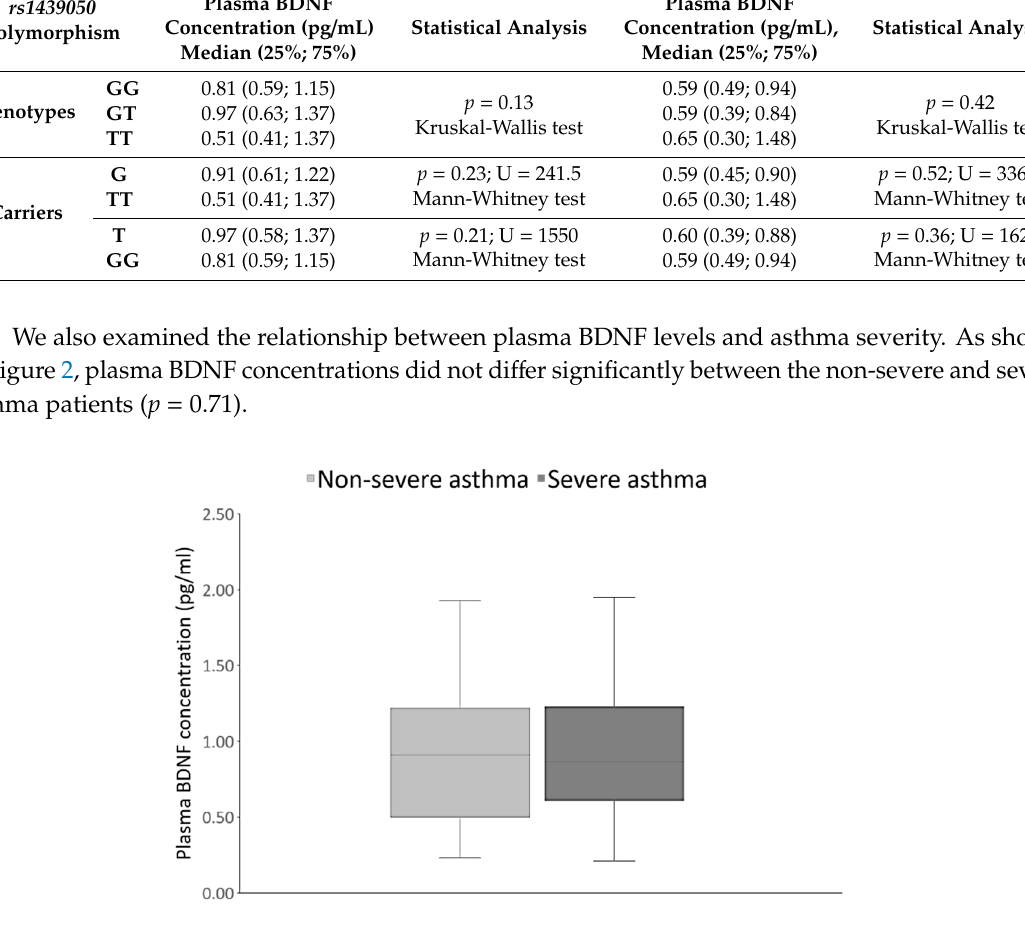
Table 5. Plasma BDNF concentration in asthma patients and healthy subjects carrying di ff erent NTRK2 rs1439050 genotypes and alleles.